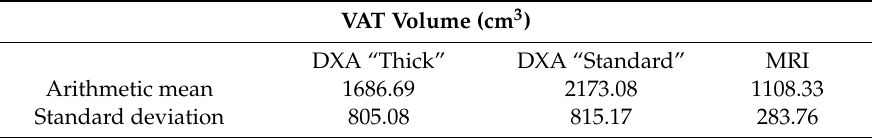
Figure 5. Relationship between VAT mass (VAT_g_d_core, in g) and VAT volume (VAT_vol_d_core, in cm 3 ) in “thick” mode, measured by DXA. The model equation shows a density of 0.9435 g/cm 3 for VAT. Table 3. Arithmetic means and standard deviations of VAT volume measured by DXA for “thick” and “standard” modes, and by